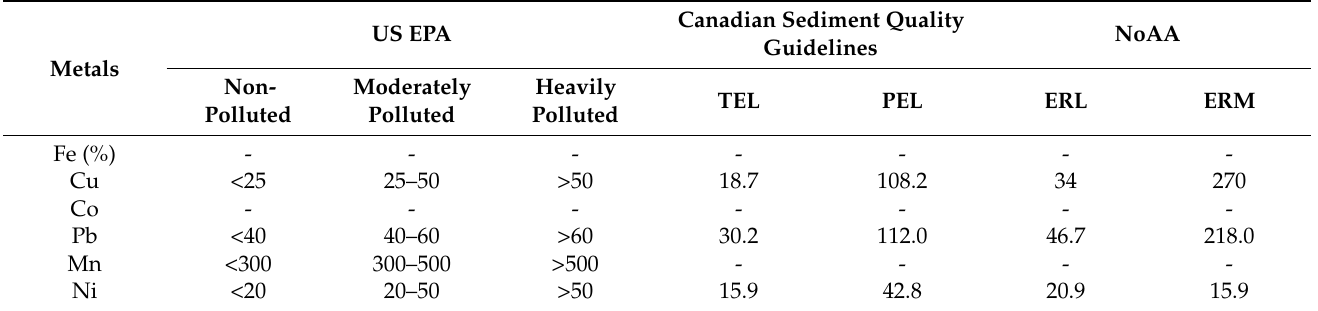
Table 2. Sediment quality guidelines (SQGs) for the analyte metals.